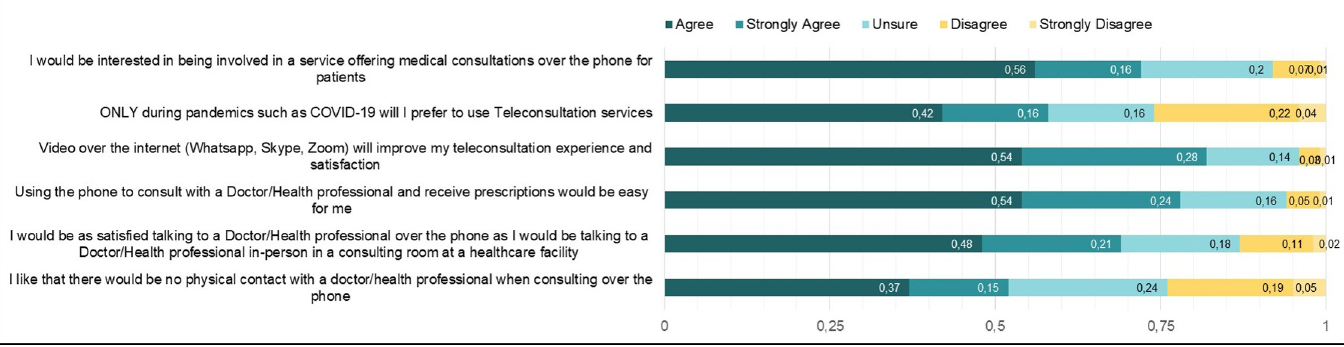
Fig 3. Healthcare consumers overall perceptions on telemedicine